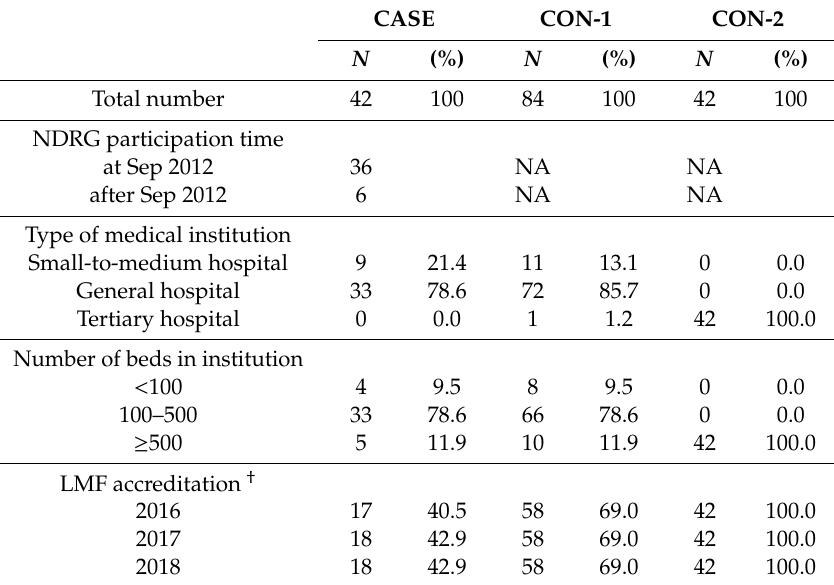
Table 1. General characteristics of study